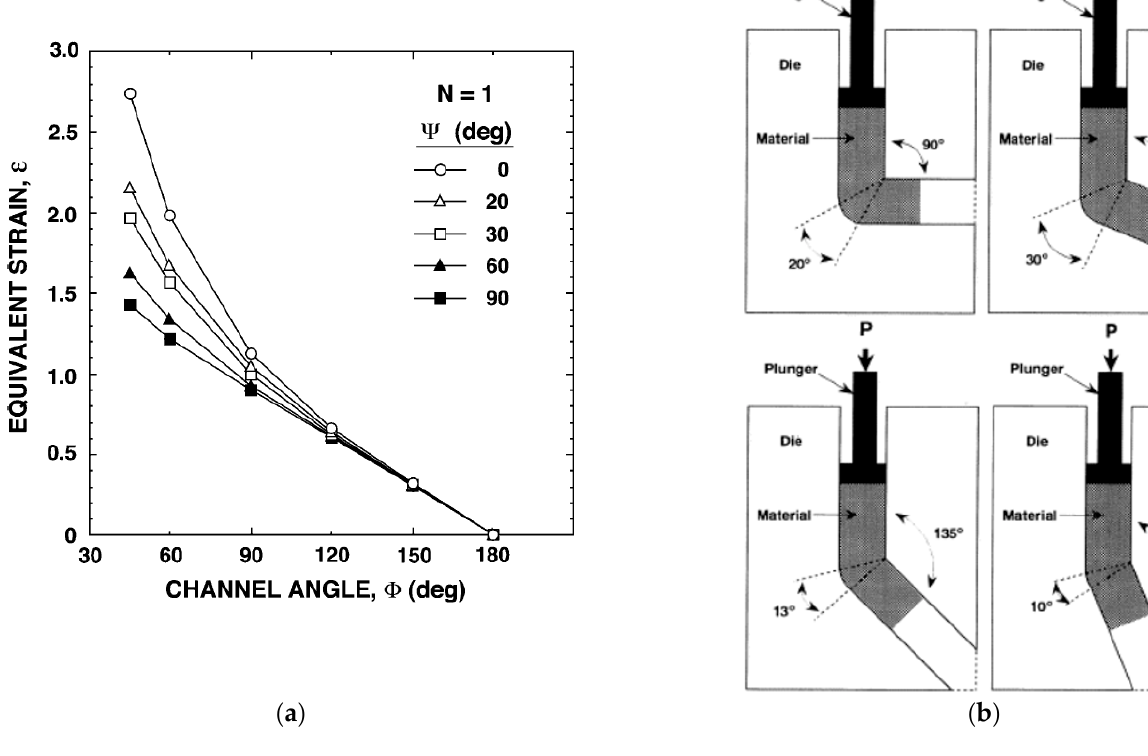
Figure 3. ( a ) Equivalent strain plot varying different die angles; ( b ) die angles ( Φ : 90°, 112.5°, 135°, 157.5° and Ψ : 20°, 30°, 13 ° , 10°) Journal of Materials Research and Technology